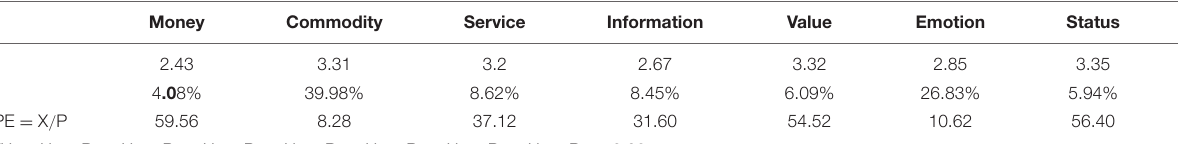
TABLE 3 | Expectation prediction data statistics.